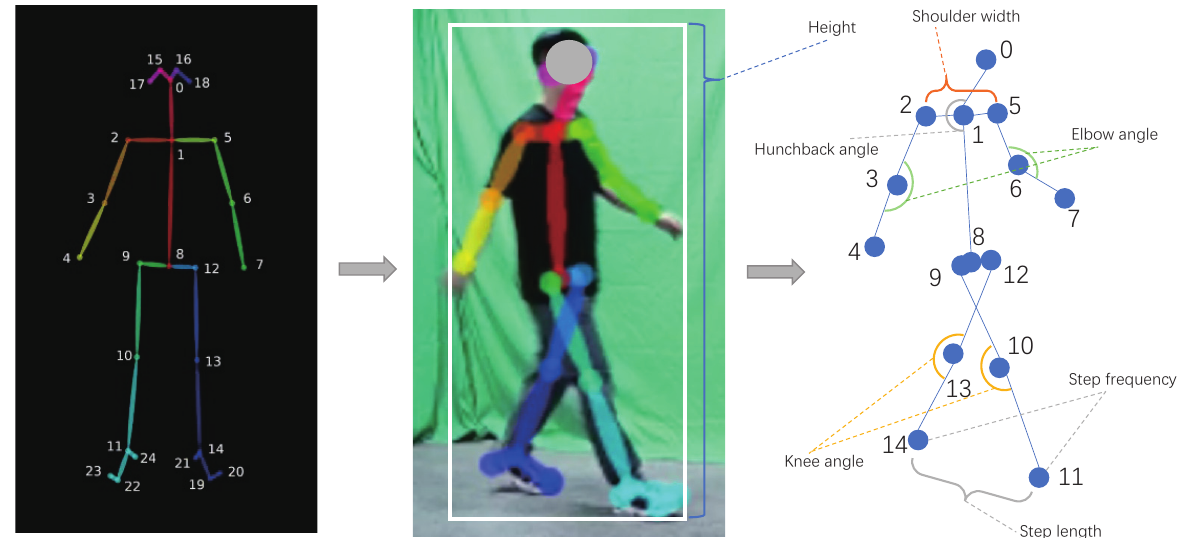
Figure 6. After obtaining the real human height from Equation (12), with the skeleton points extracted from OpenPose [23], this paper can obtain 7 real human physiological information parameters: height, shoulder width, hunchback angle, elbow angle, knee angle, step length, and step frequency.